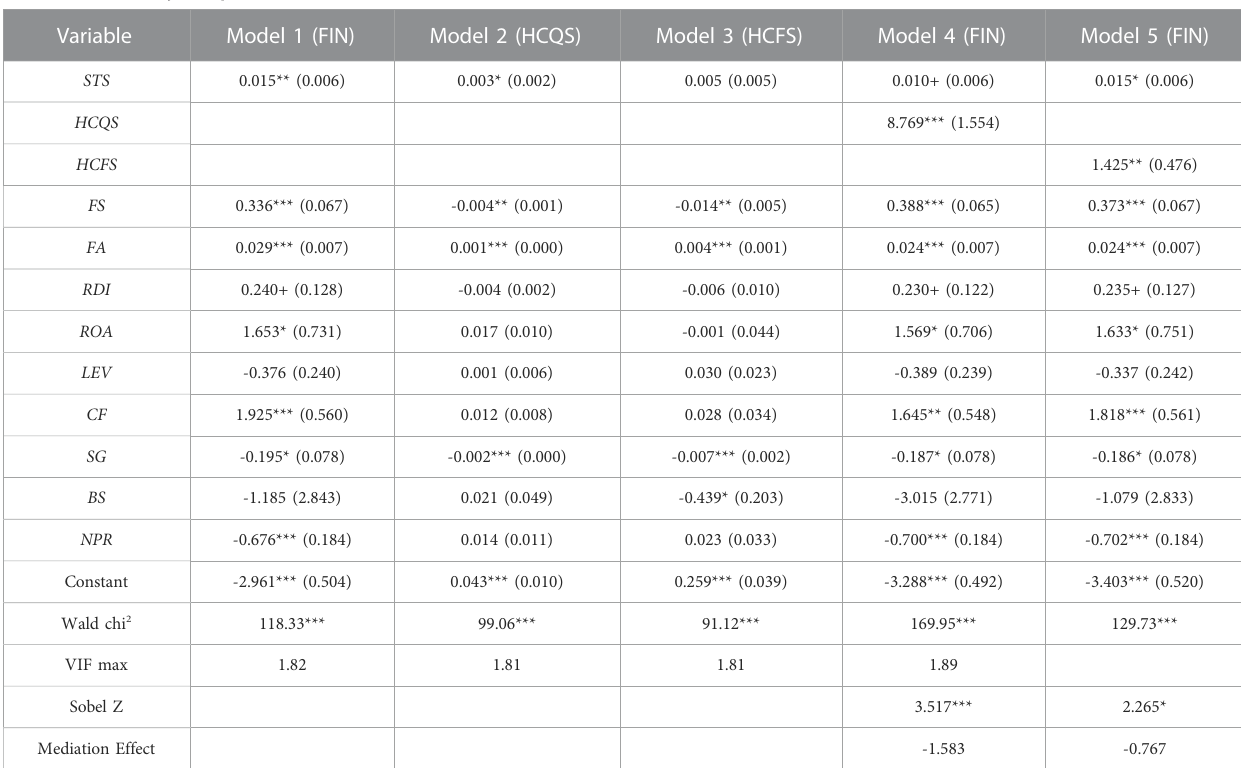
TABLE 9 Robust analysis-dependent variable.